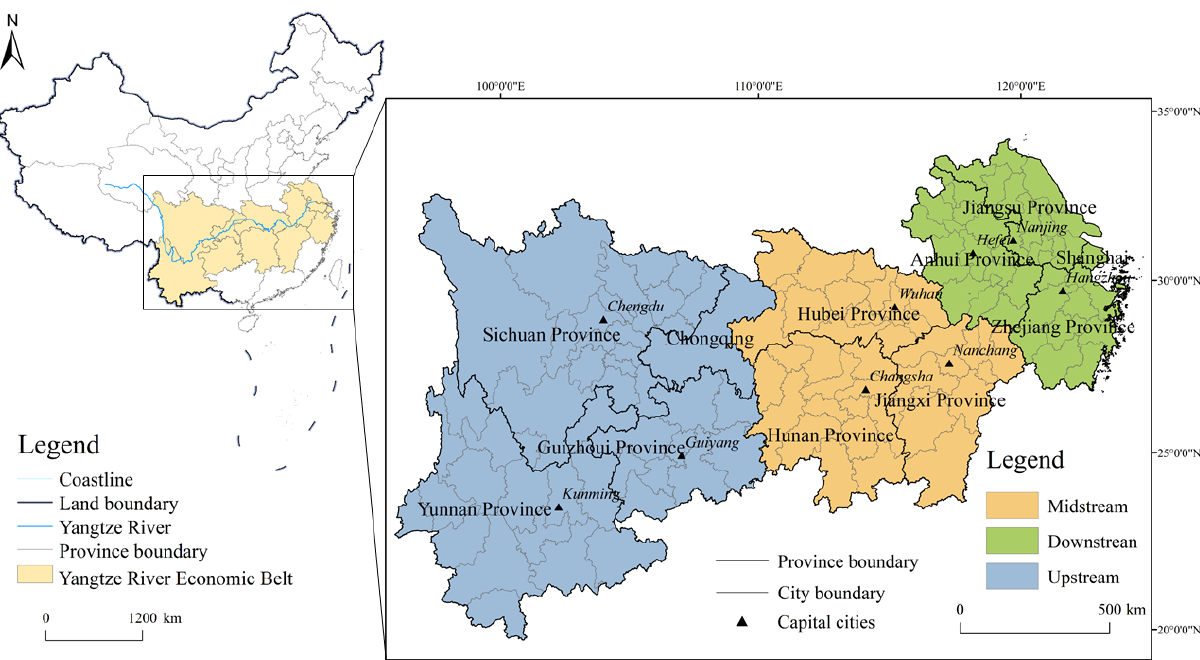
Figure 1. Location of the YREB in China.